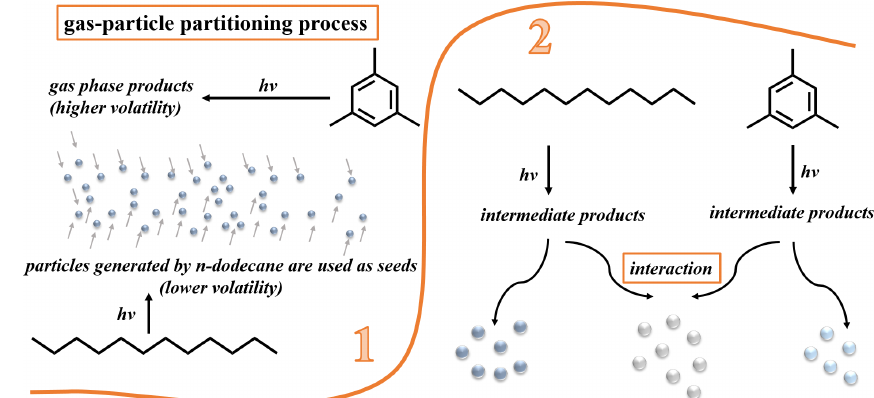
Figure 2. The possible conjectures of the reaction processes.